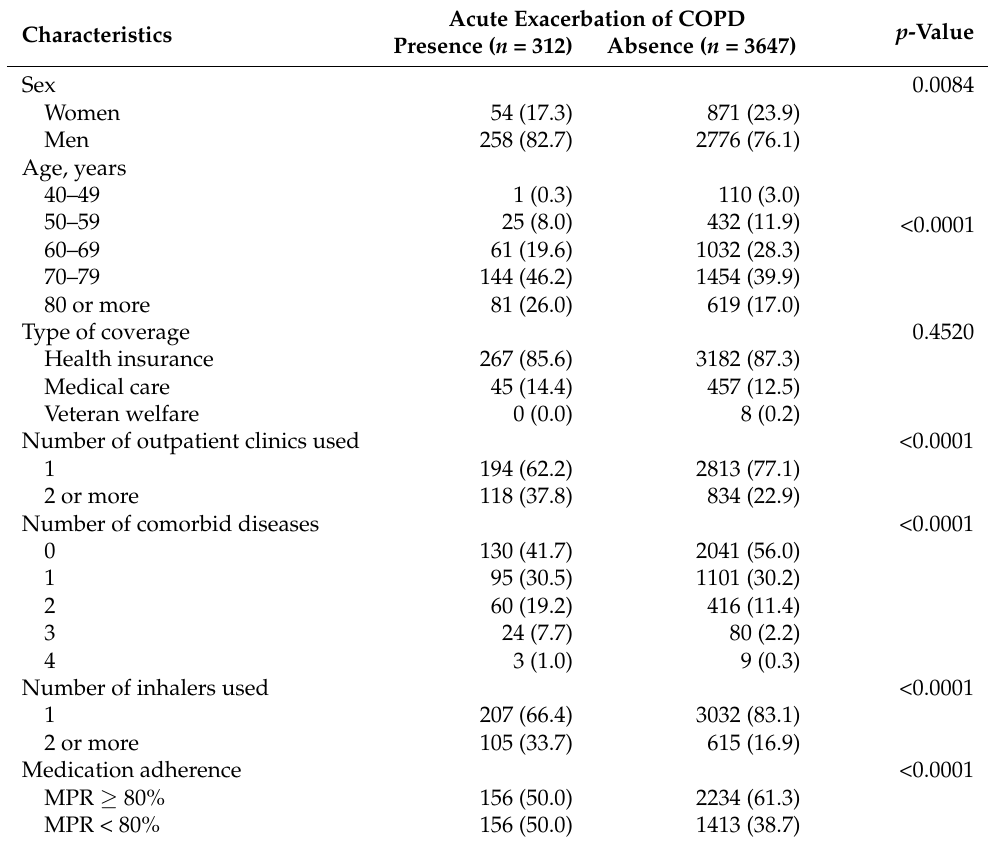
Table 2. Clinical characteristics and long-acting inhaler adherence according to the presence or absence of COPD exacerbation.